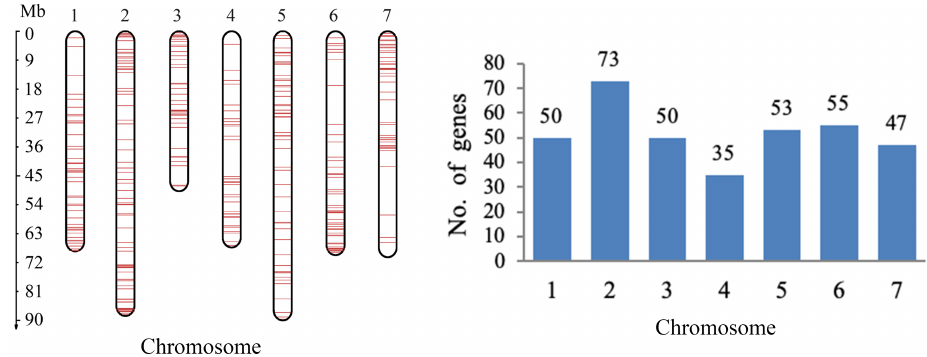
Figure 5. Distribution of the 363 studied single-copy nuclear genes (SCGs) in the ’Old Blush’ genome.